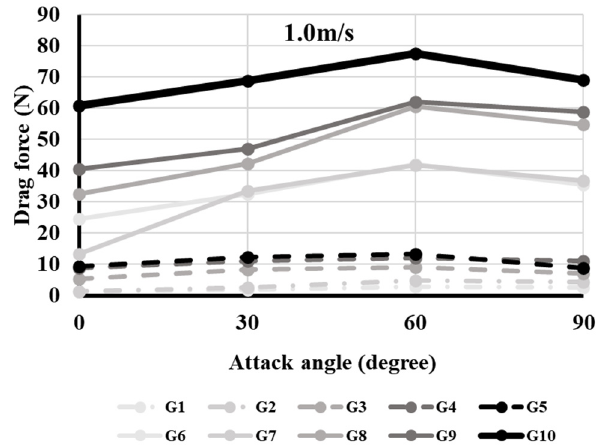
Figure 4. The drag forces of different ground gears and attack angles. (Straight line: cylinder-shaped, thick straight line: sphere-shaped, dotted line: ellipsoid-shaped).